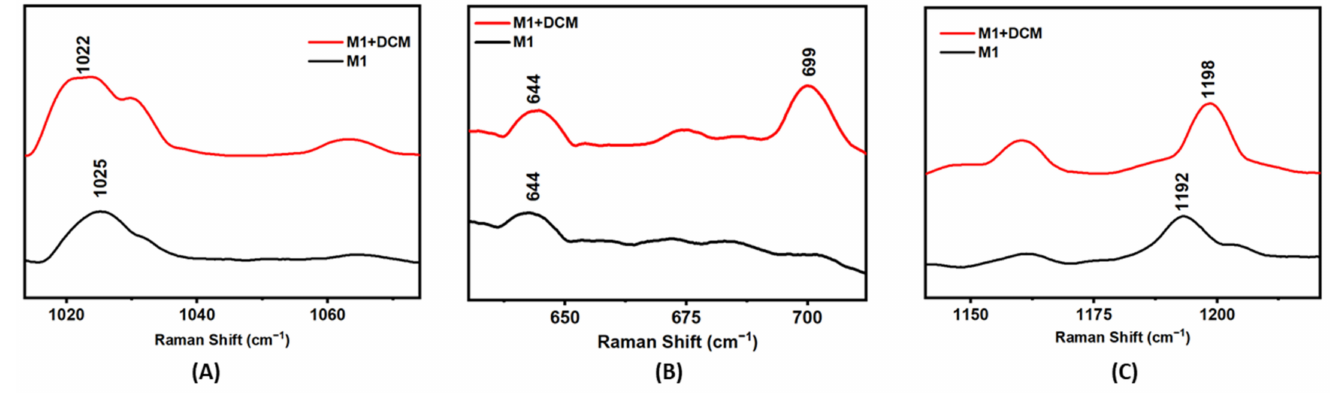
Figure 9. Enlarged views of RAMAN spectra (partwise): ( A ) The bending peak for C-H(c) of vinyl (=CH 2 ), ( B ) the cis C-H(d) bending vibrations of vinyl (=CH 2 ) and symmetric stretching C- Cl(a) of treated DCM at 699 cm − 1 , ( C ) phenyl ring vibrations; (f) for mono-substituted phenyl of triphenylphosphine (PPh 3 ) increased from 1192 to 1198 cm − 1